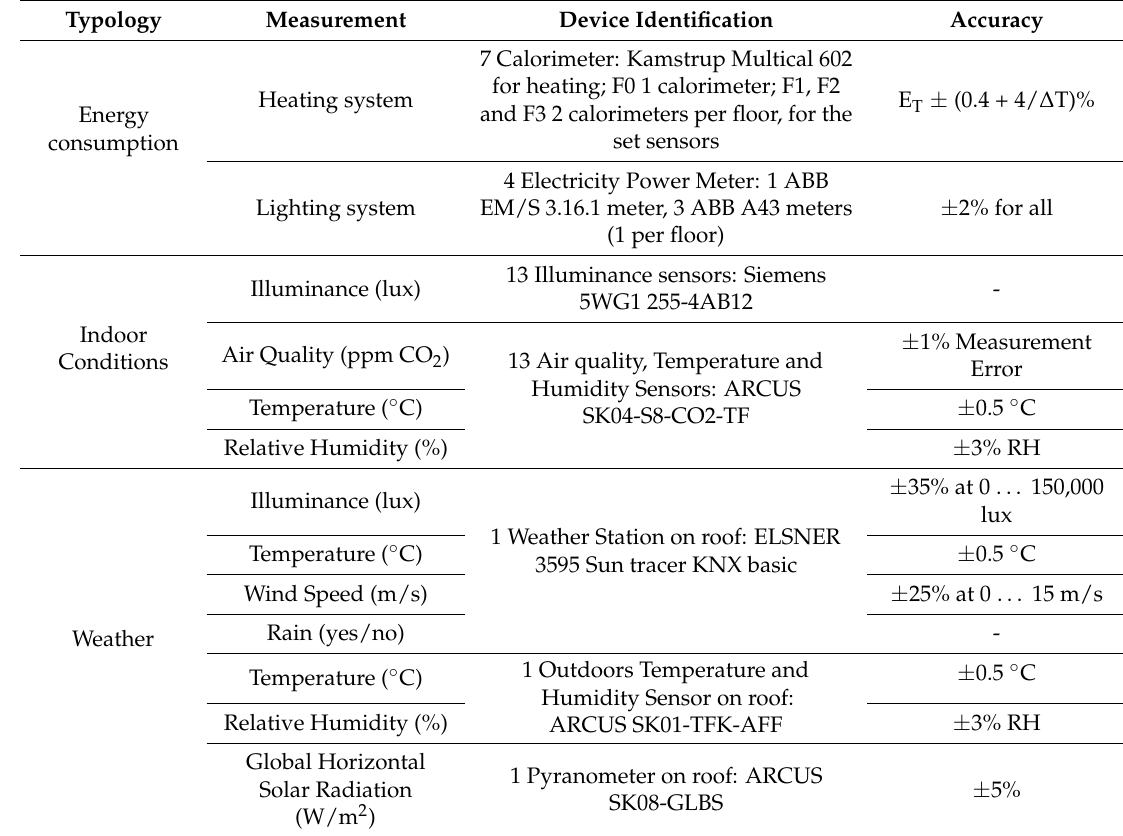
Table 6. Monitoring system of a public building of the University of the Basque